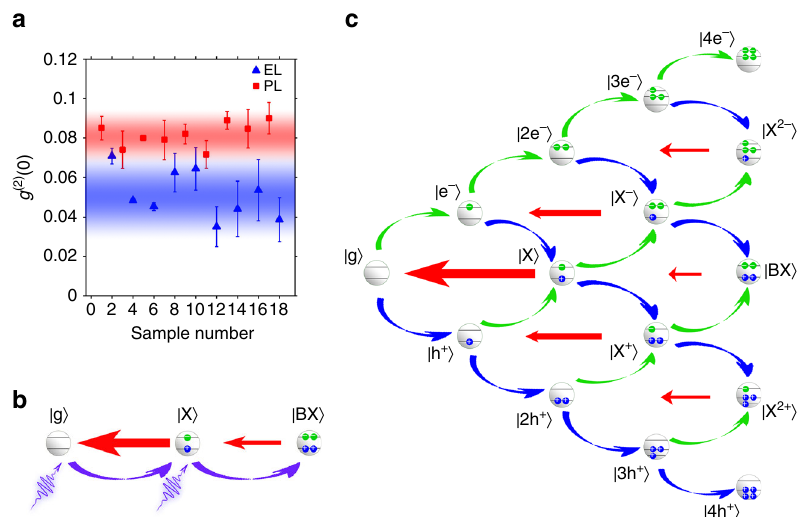
Fig. 3 Single-dot electroluminescence and single-dot photoluminescence. a Lowest g 2 (0) values from the two sets of 9 quantum dots under electro- excitation (blue) and photo-excitation (red), respectively, The g (2) (0) value equals the average of four data points around zero time delay and error bars depict the standard error of these four measurements. b Carrier dynamics of photoluminescence for a non-blinking quantum dot. The violet curved arrows indicate the generation of a new electron – hole pair by absorbing a single excitation photon, while the straight red arrows indicate the recombination of one individual electron – hole pair. c Schematic drawings of carrier dynamics of electroluminescence. Here g j i ; e (cid:3) j i ; h þ